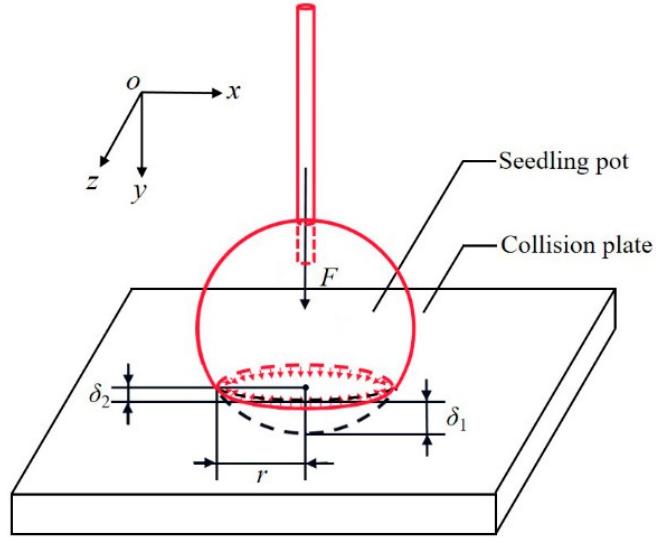
Figure 4. Schematic diagram of the collision between the seedling and collision plate: r is the radius of the contact circle, m; δ 1 is the compression of the seedling pot, m; δ 2 is the compression of the collision plate, m; o-xyz is the space coordinate system.